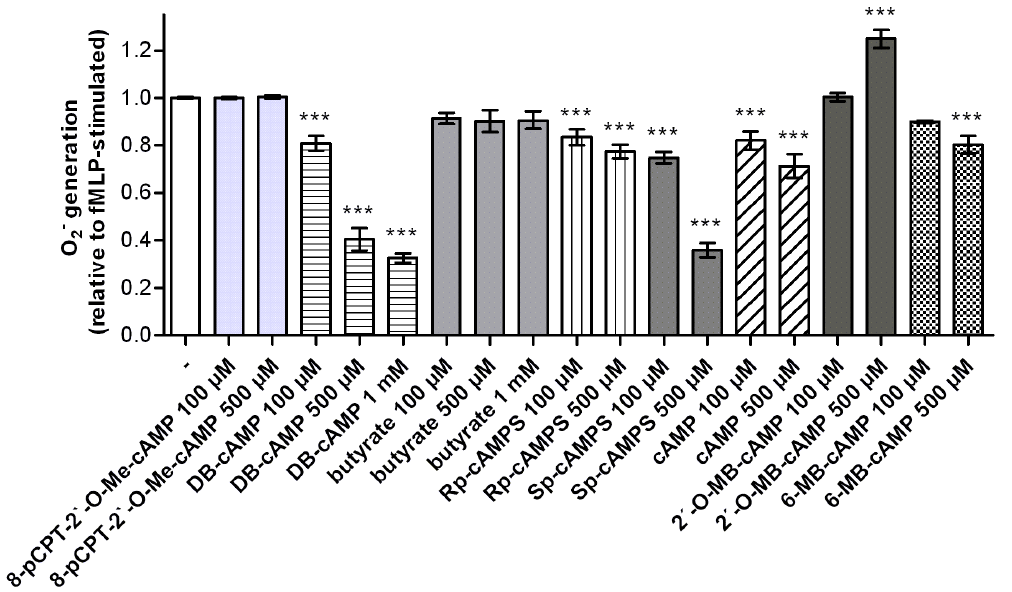
Figure 9. Effects of cAMP, butyrate and cAMP analogs on fMLP-stimulated O 2 N 2 production. O 2 N 2 production in human neutrophil granulocytes (1 6 10 5 cells per well) was monitored by measuring superoxide dismutase-inhibitable reduction of ferricytochrome c at 550 nm as described in Materials and Methods . Data shown (mean 6 S.E.M.) are from three to seven independent experiments, performed in triplicate. Data were analyzed for statistical significance relative to the control (-, set to 1.0) using one-way ANOVA, followed by Dunnett’s multiple comparison test (***p , 0.001).